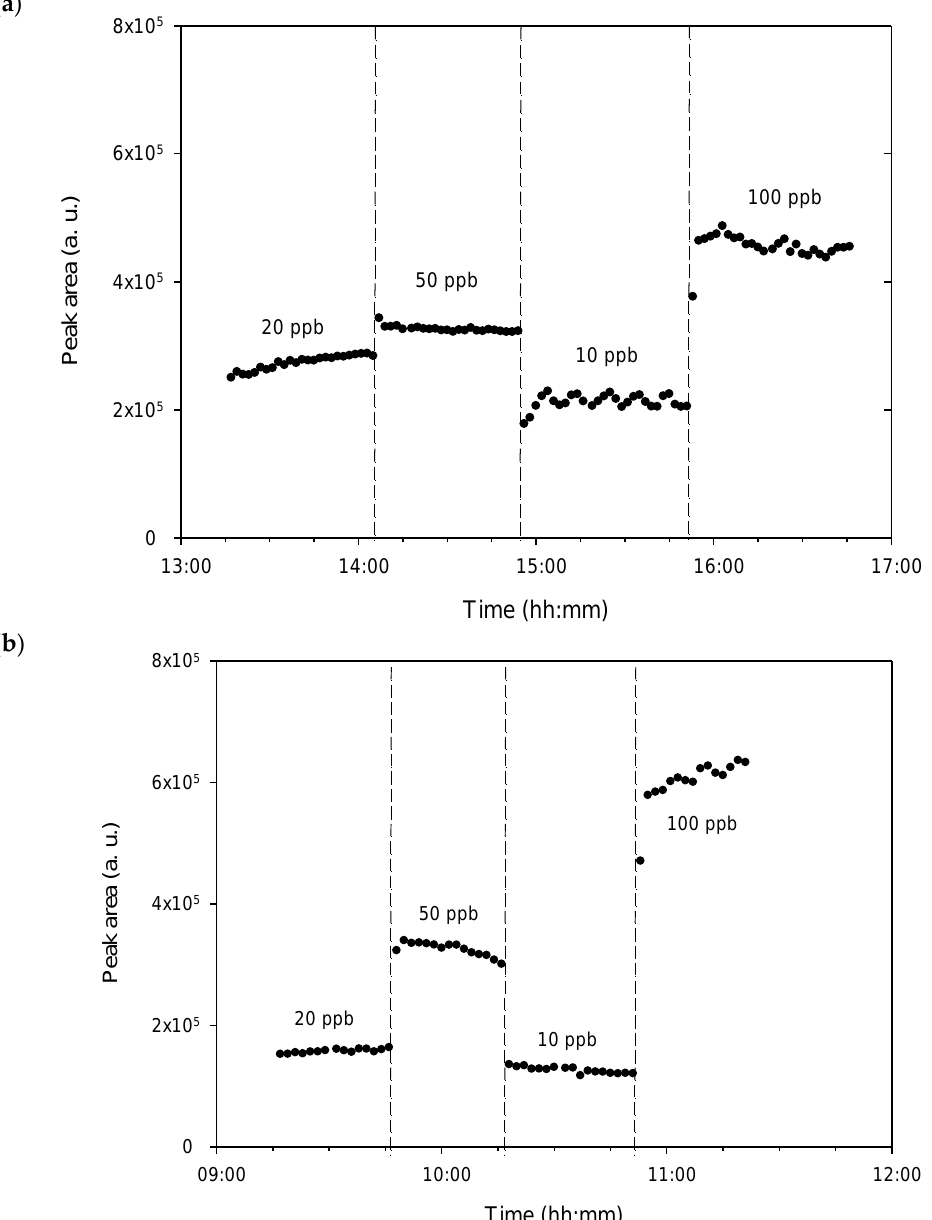
Figure 6. Total BTEX peak area on a logarithmic scale vs. time obtained either ( a ) without any micromixer or ( b ) with the gas train generator coupled to a 4-stage micromixer for gas mixtures of 20, 50, 10 and 100 ppb generated from a gas cylinder of BTEX at 1000 ppb of each compound. Concentrations of 20, 50, 10 and 100 ppb were generated with respectively P pol = 200 mbar and t carrier = 4 s, P pol = 200 mbar and t carrier = 1 s, P pol = 200 mbar and t carrier = 9 s, and P pol = 400 mbar and t carrier = 1 s. The total flow rate was fixed at Q = 25 NmL min −1 .